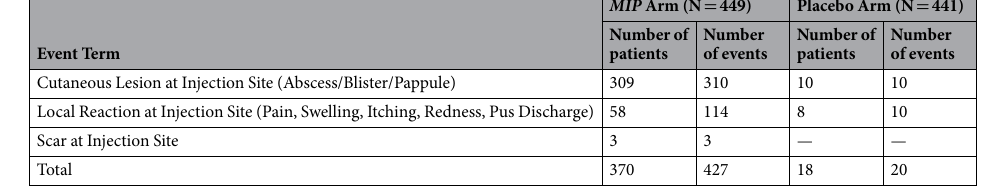
Table 4. Vaccine related adverse events.